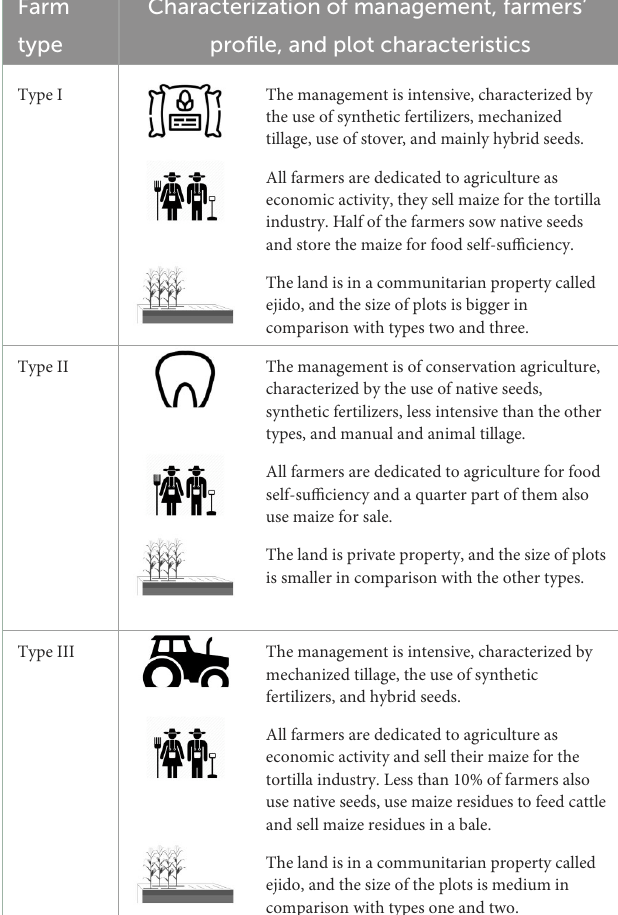
TABLE 4 Integration of management, farmers’ profile, and plot characteristics.